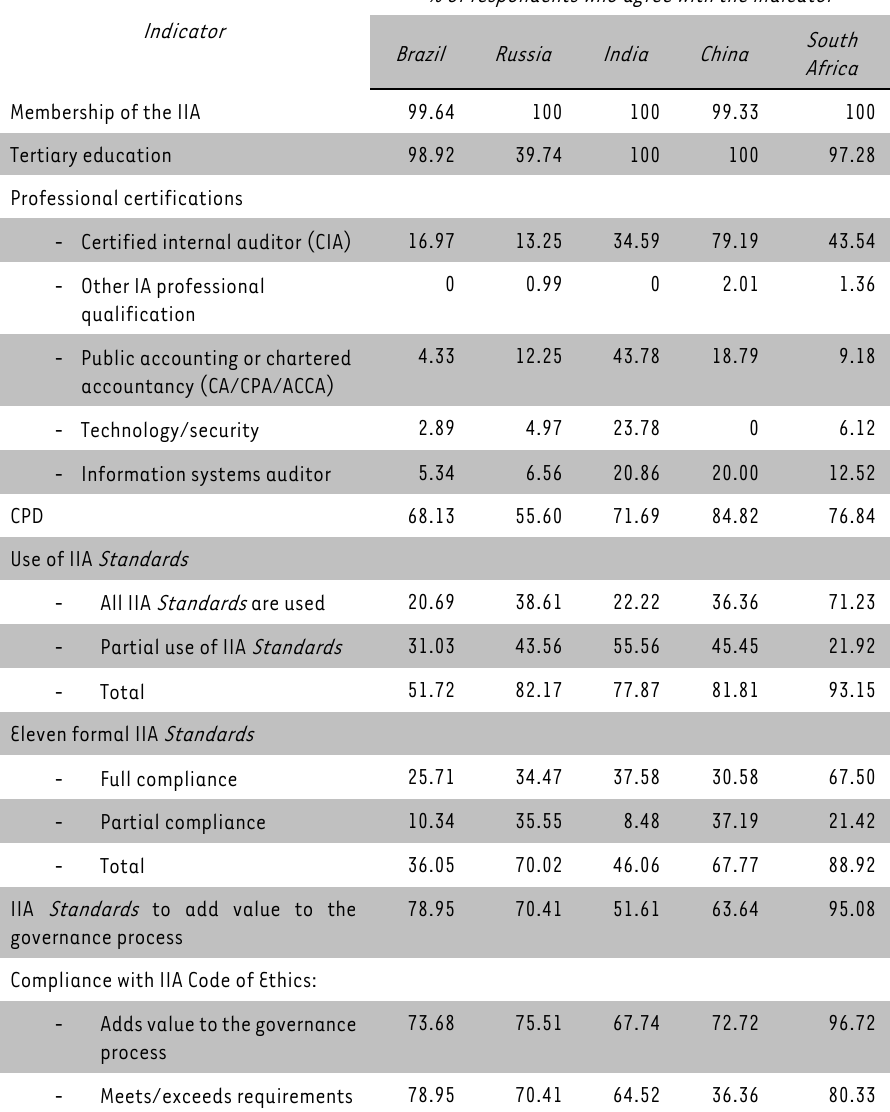
TABLE 2: Normative pressures